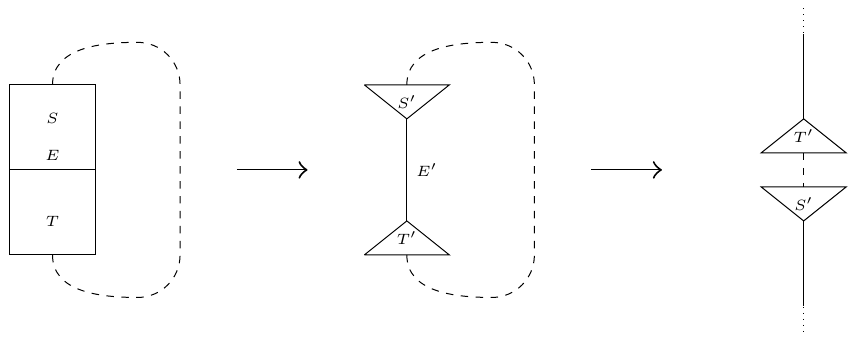
Figure 2 . From left to right: two surfaces S and T are glued to each other along a − 1 curve E . The dashed line represents a collection of surfaces joining S and T in some other direction. Flopping E leads to the second figure with S ′ being a blow-down of S and T ′ being a blow-down of T . The volume of E ′ can then be sent to infinity leading to a geometry (shown in the last figure) in which S ′ and T ′ are joined only via the collection of surfaces denoted by dashed